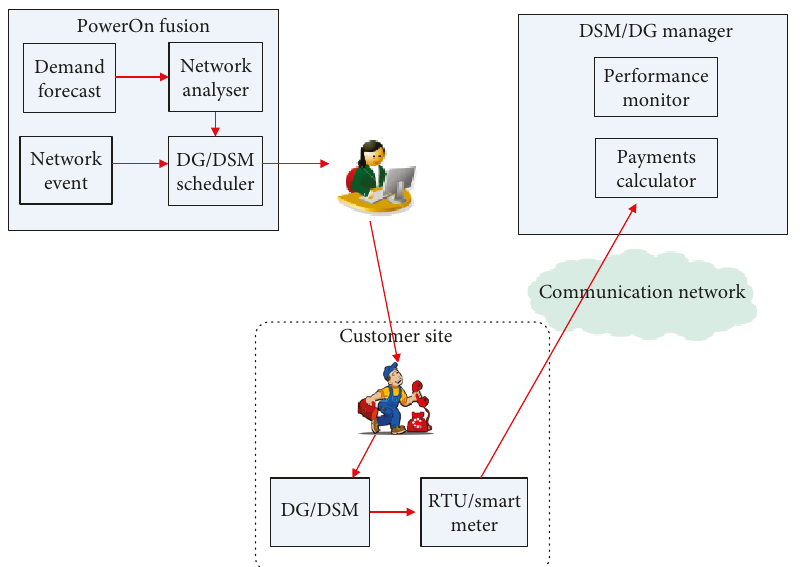
Figure 4: Commercial trials representation: DG/DSM.